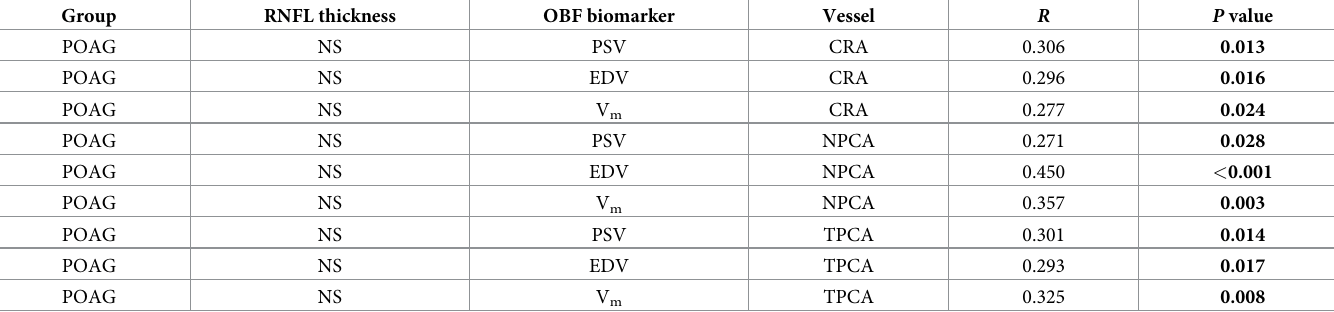
Table 4. Correlations corrected for age, central corneal thickness, intraocular pressure and the presence of hypertension between RNFL thickness and OBF biomarkers. Group RNFL